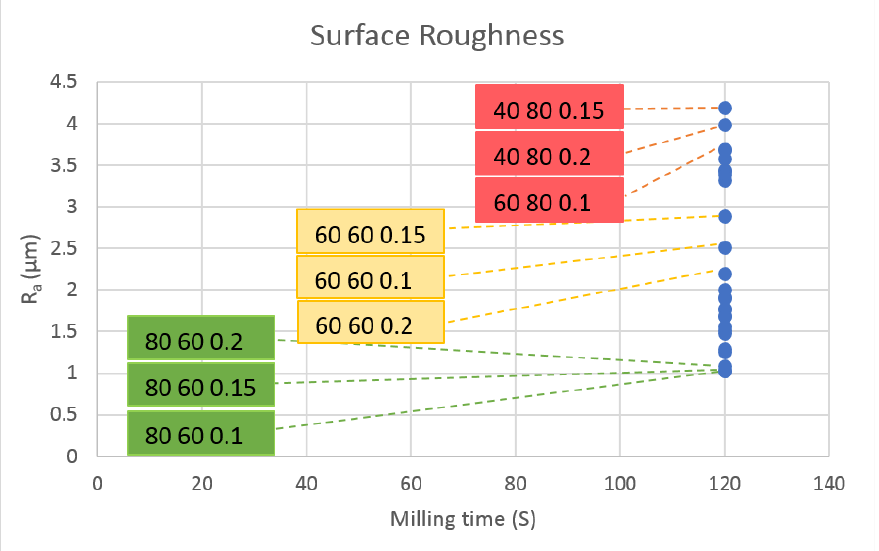
Figure 10. The recorded values of surface roughness under different cutting conditions.